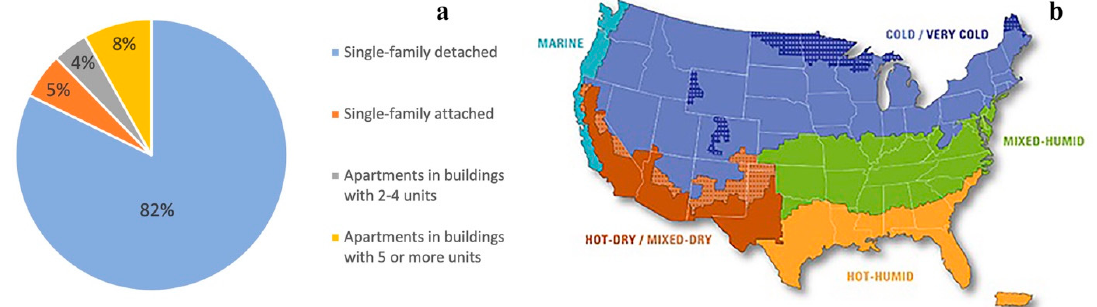
Figure 2. ( a ) Building type breakdown, and ( b ) US climate region map